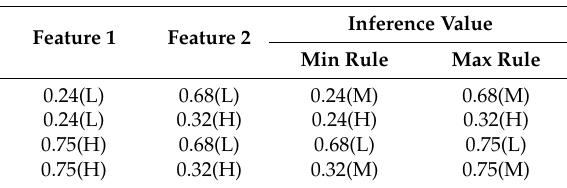
Table 3. An example of the Inference Value produced by Min and Max rules with fuzzy rule table of Table 2a.